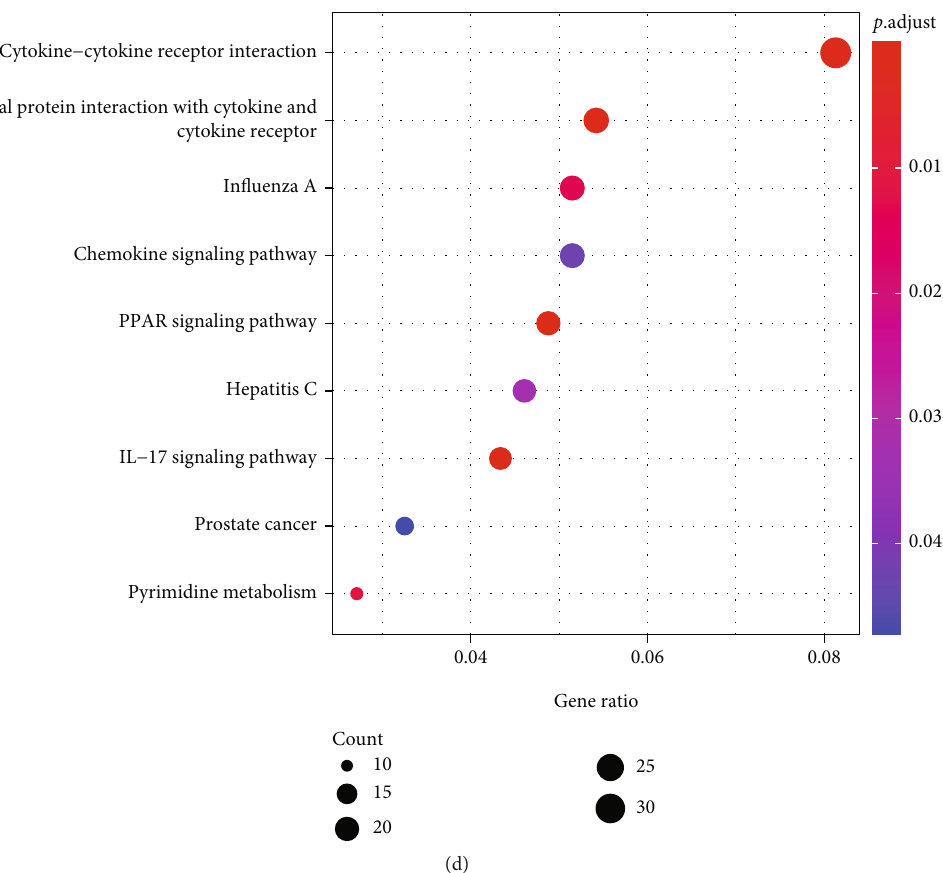
Figure 1: Analysis of DEGs between psoriasis lesions and healthy controls in GSE13355. (a) Volcano map of DEGs in GSE13355. (b) Heat map of top 100 DEGs between psoriasis and healthy samples in GSE13355. (c) Top 10 enriched GO terms by 767 DEGs in each category. (d) Top 10 enriched KEGG pathways by 767